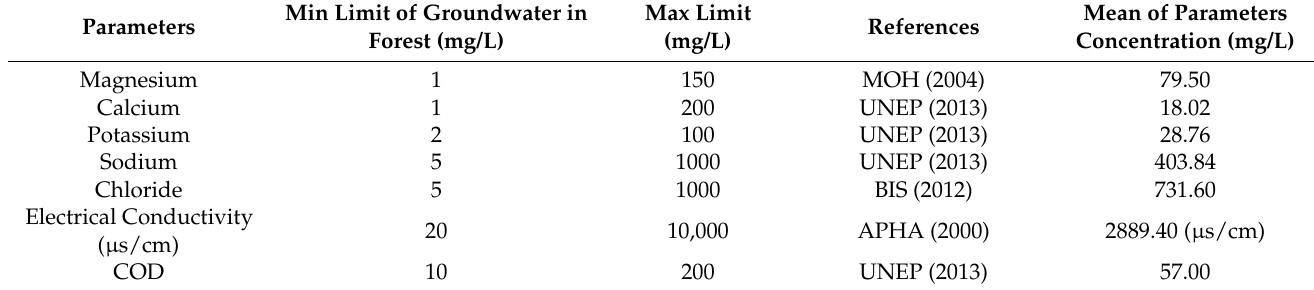
Table 8. The minimum and the maximum limits value of groundwater from different